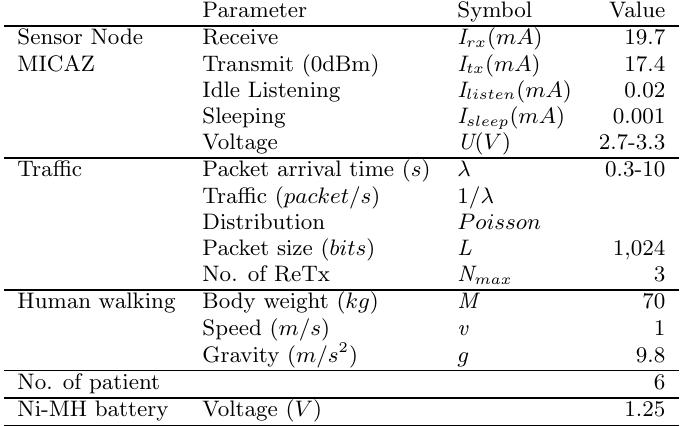
Table 2: Simulation parameters and QoS require-